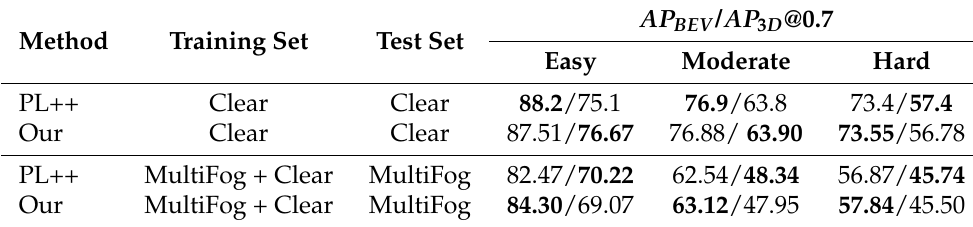
Table 4. Comparison with Pseudo-LiDAR++ [68] method, with IoU = 0.7, best results shown in